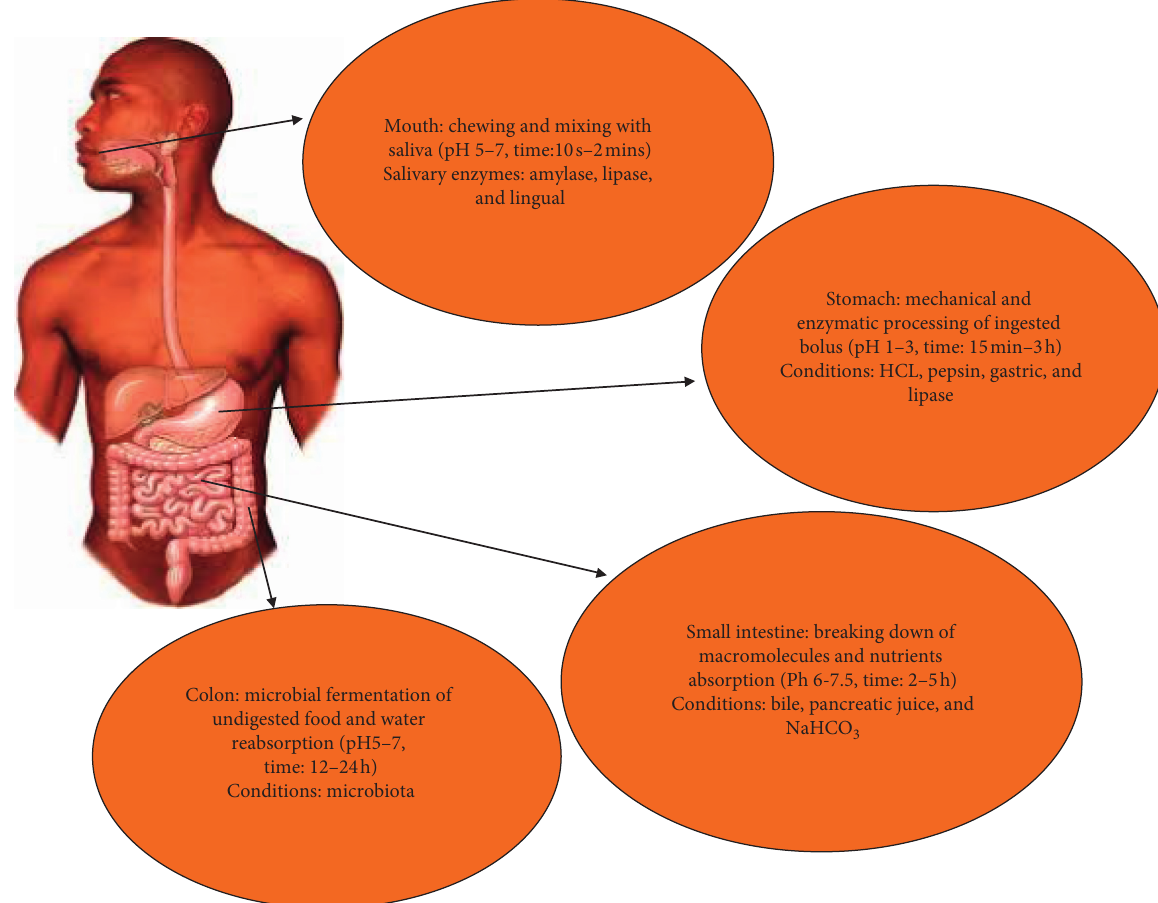
Figure 2: The main mechanisms of the human digestive